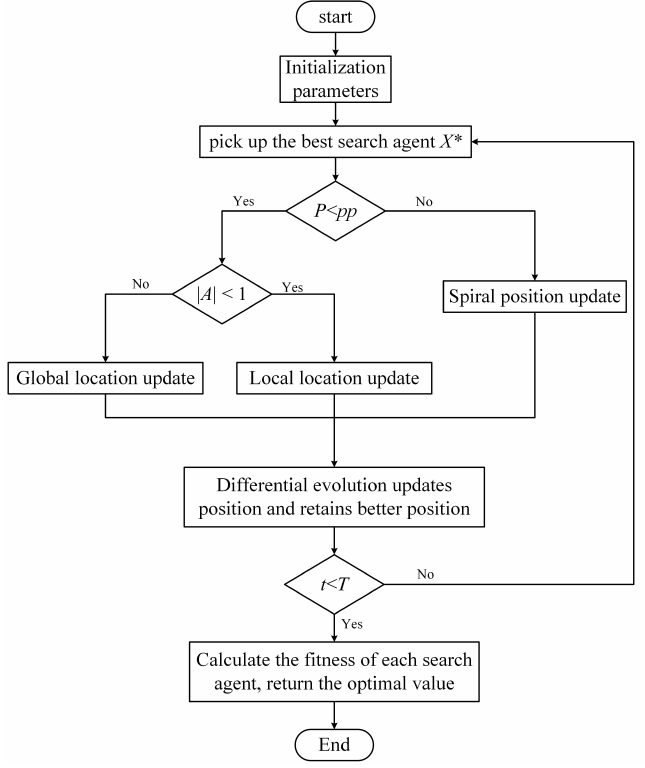
Figure 6. Flow chart of improved whale optimization algorithm. The pseudo code of our improved whale optimization algorithm is given as Algorithm